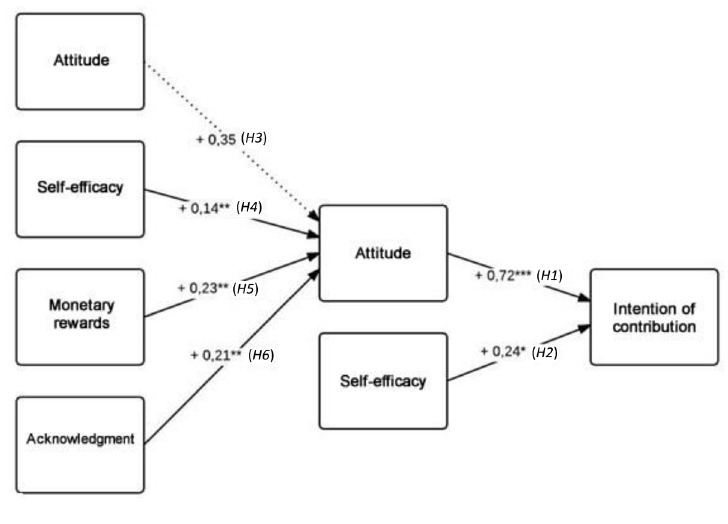
Figure 3. Calculated effects – exploratory model